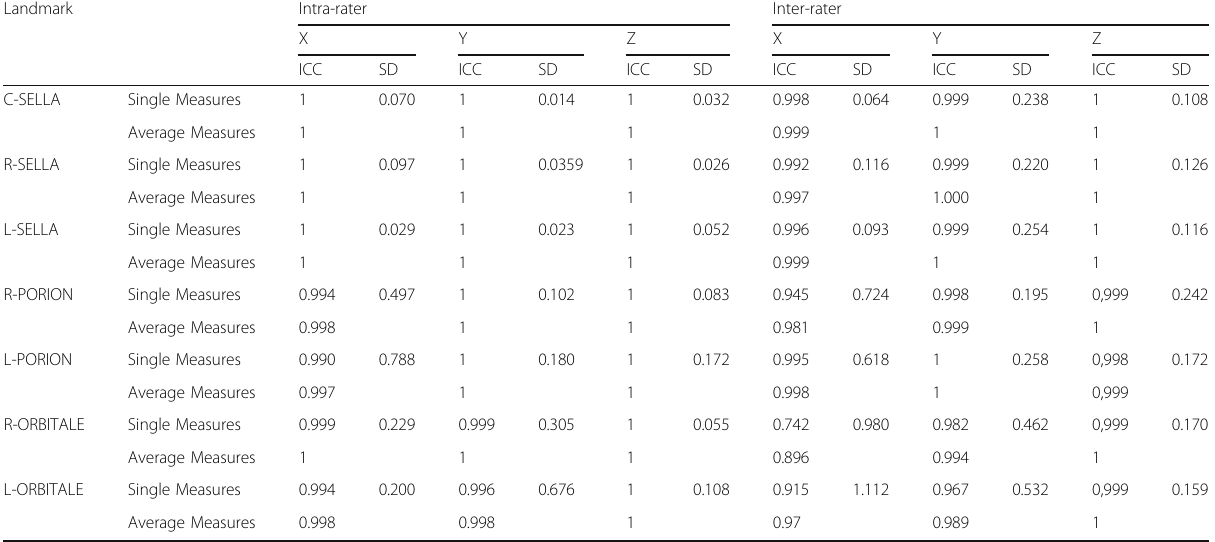
Table 4 Intraclass Correlation Coefficient (ICC) and Standard deviation (SD) of Intra- and Inter- rater reliability error for landmarks digitization of X, Y and Z coordinates for Reference system